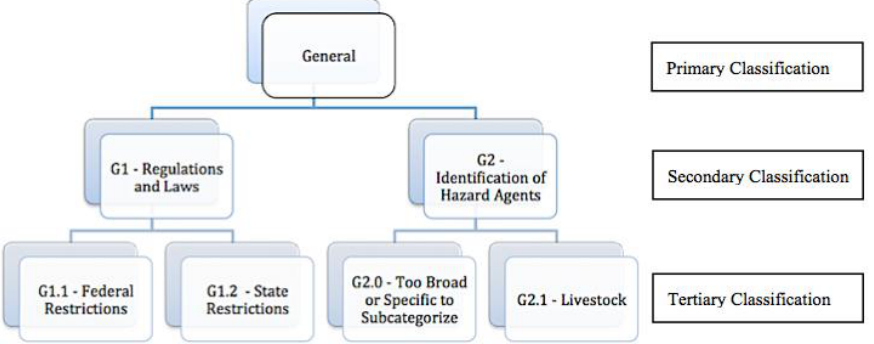
Figure 2. Learning Outcome Hierarchical Classification Example.